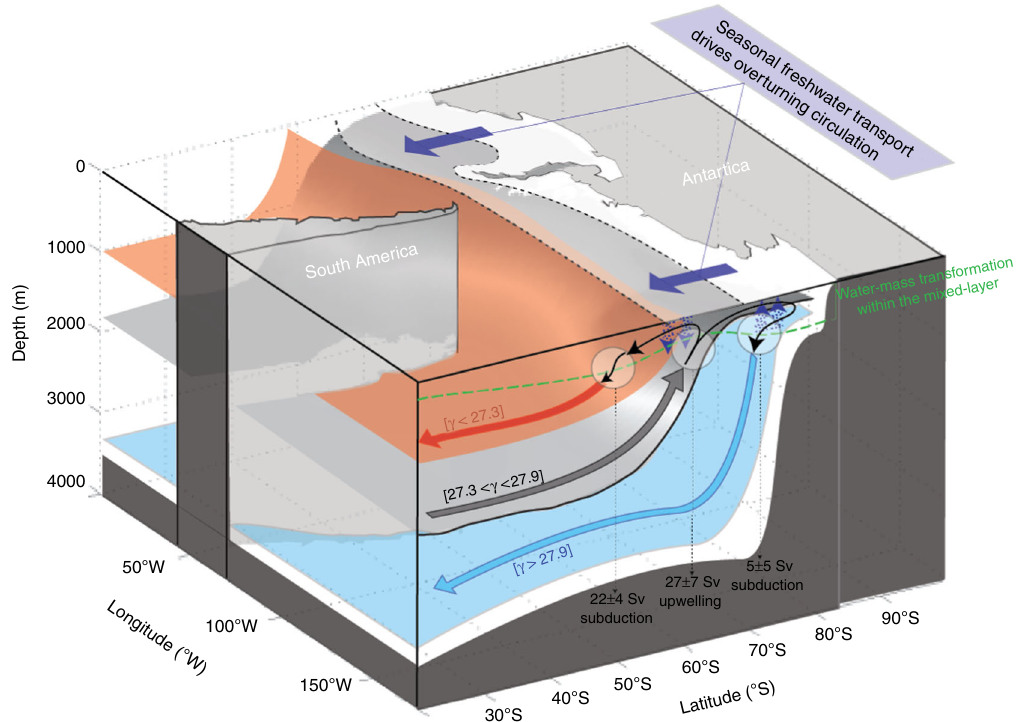
Fig. 1 Water-mass transformation within the Southern Ocean mixed-layer under sea-ice. Schematic cross-section illustrating the main water-masses in the Southern Ocean (Antarctic Intermediate and Mode Waters in red, Circumpolar Deep Waters in gray, and Dense Shelf Waters and Antarctic Bottom Waters in blue) and their interaction with ice and the surface. The water-masses are denoted by their neutral density values and the arrows corresponding to each water-masses indicate subduction (downward) or upwelling (upwards). The violet arrows illustrate the effect of northward sea-ice extent and freshwater transport. The green line is the